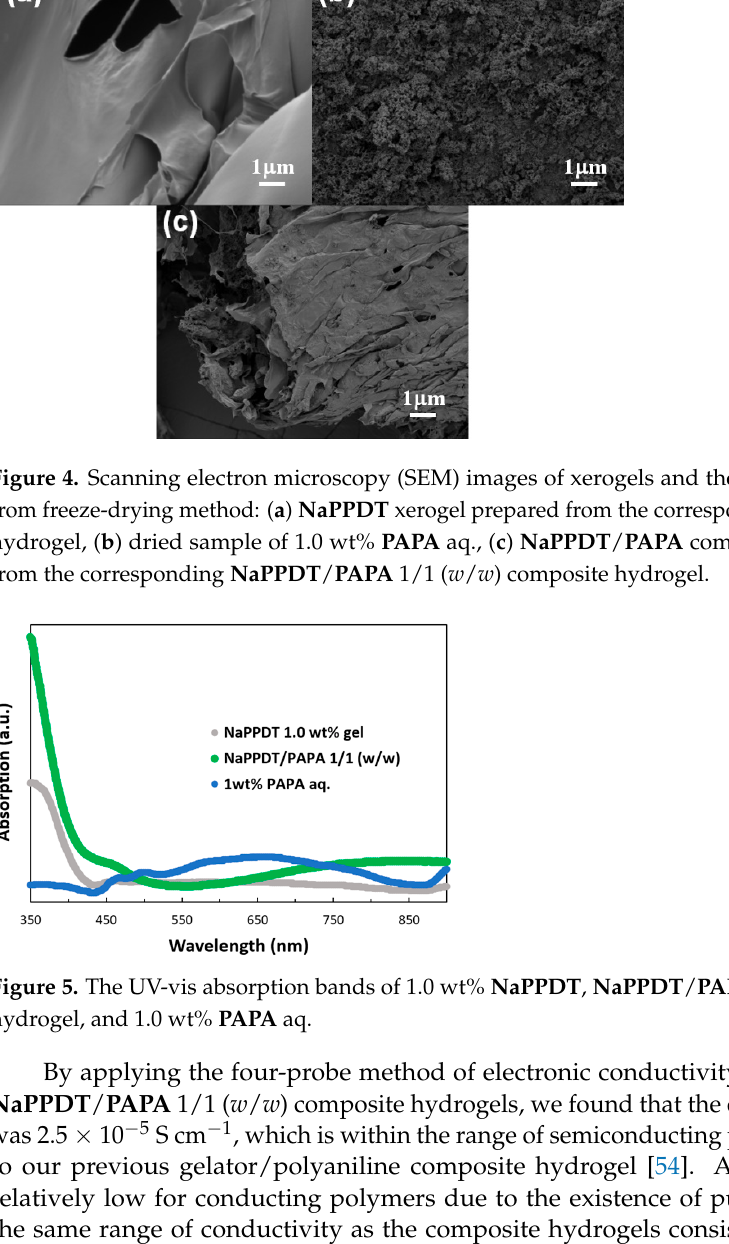
Figure 5. The UV-vis absorption bands of 1.0 wt% NaPPDT , NaPPDT / PAPA 1/1 ( w / w ) composite hydrogel, and 1.0 wt% PAPA aq.